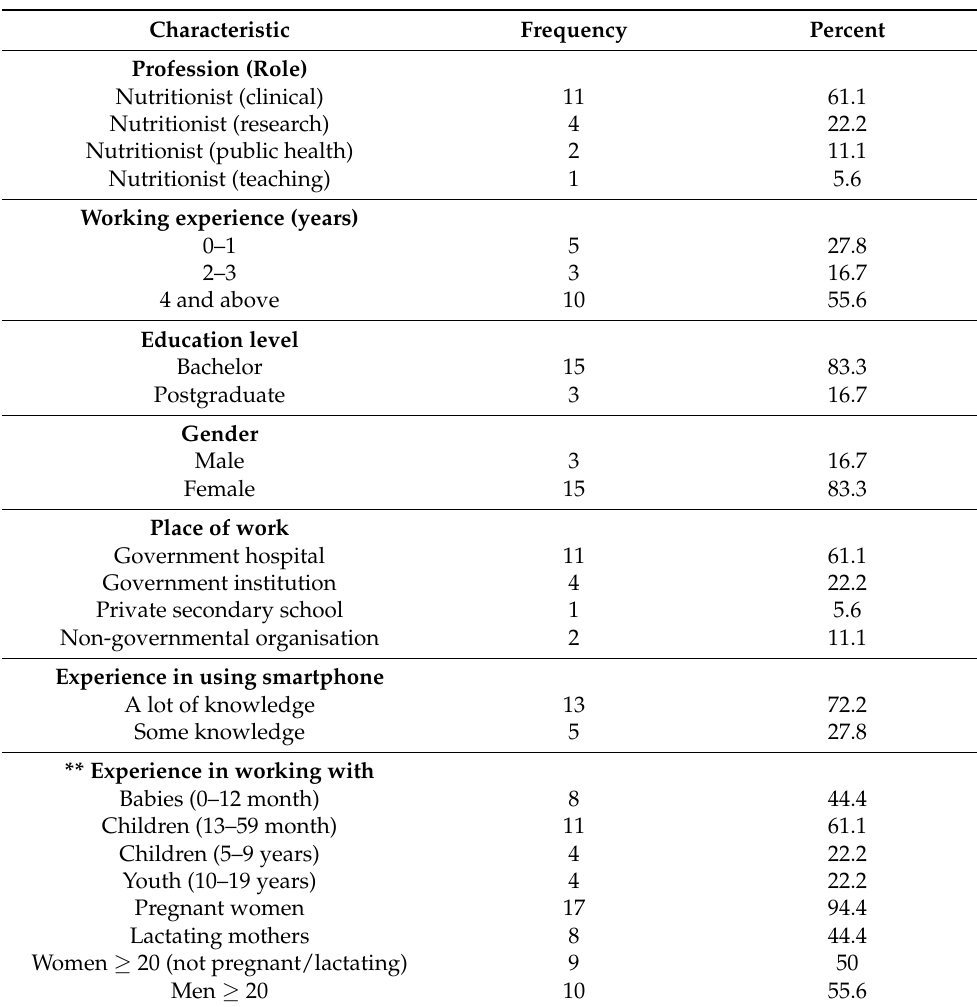
Table 2. Participants’